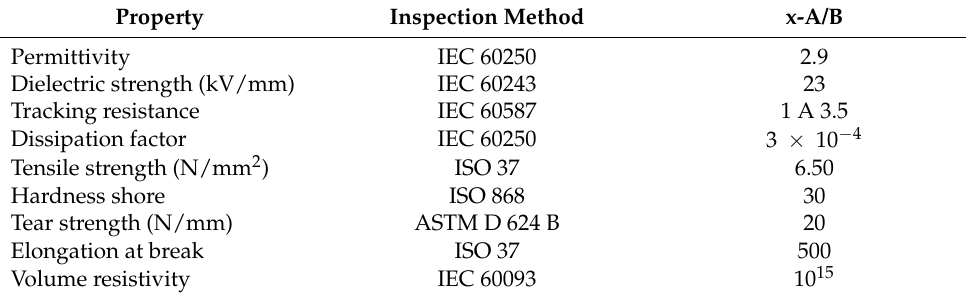
Table 1. Characteristics of x-A/B bicomponent SiR materials.